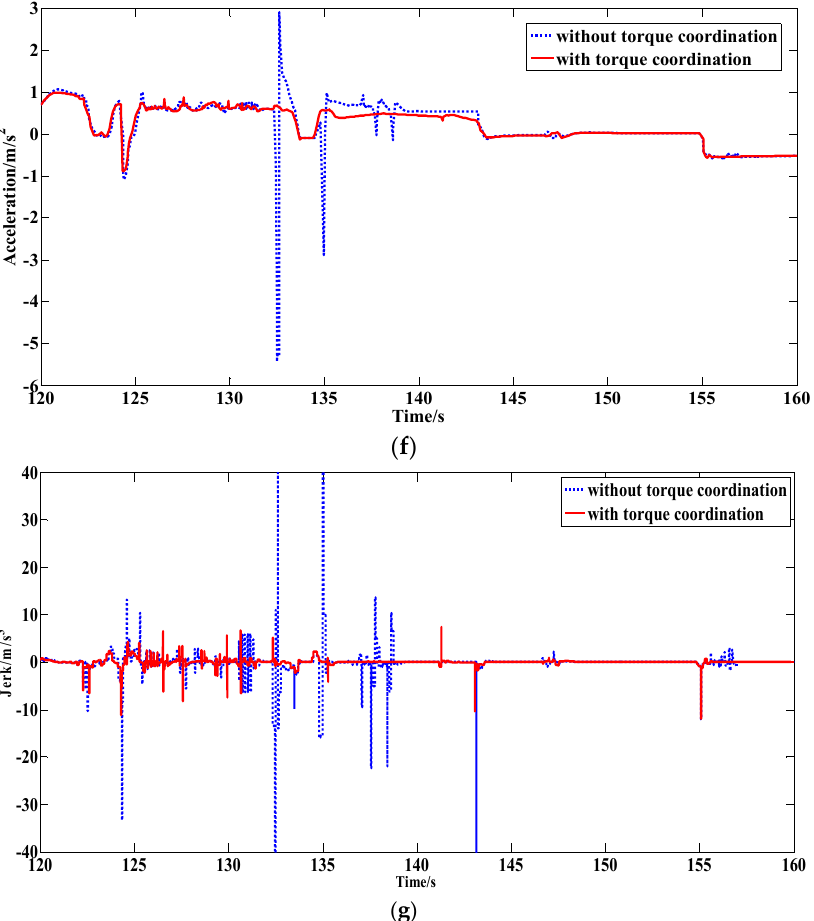
Figure 5. Simulation results and comparison curve of energy management strategy (EMS) with and without the torque coordination control: ( a ) Clutch engagement over time; ( b ) Output torque of engine; ( c ) Output torque of motor; ( d ) Vehicle demand velocity and current velocity; ( e ) Vehicle demand velocity and current velocity (amplification); ( f ) Vehicle acceleration; ( g ) Vehicle jerk.